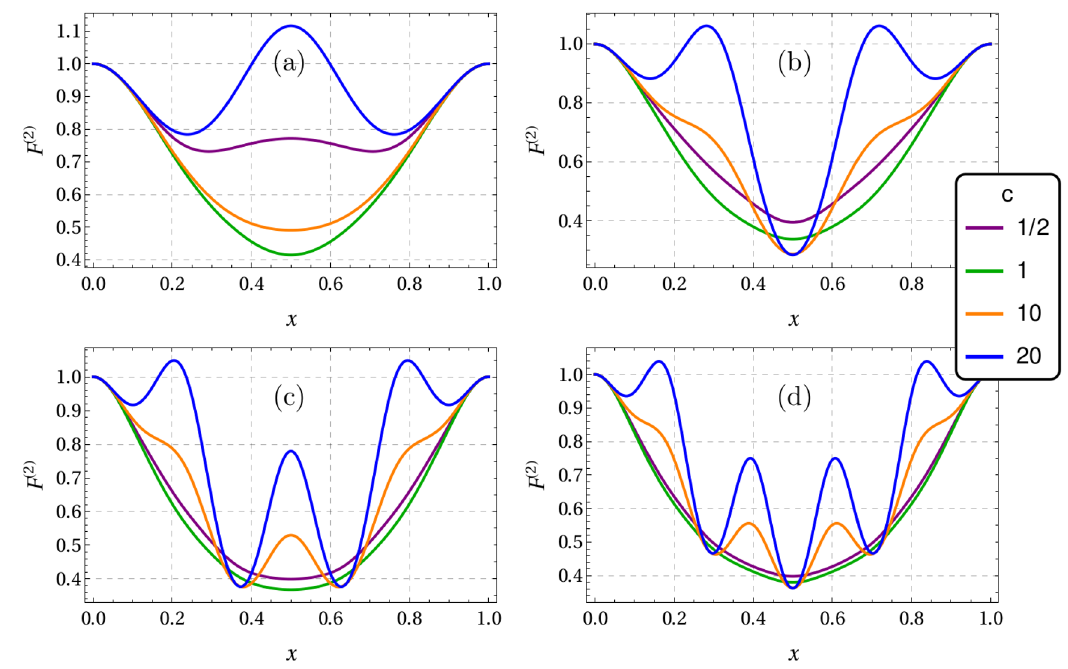
Figure 2 . The correlator F (2) for (a) | s i = L − 2 | 0 i , (b) | s i = L − 3 | 0 i , (c) | s i = L − 4 | 0 i , (d) | s i = | s i L − 5 | 0 i , for several values of the central